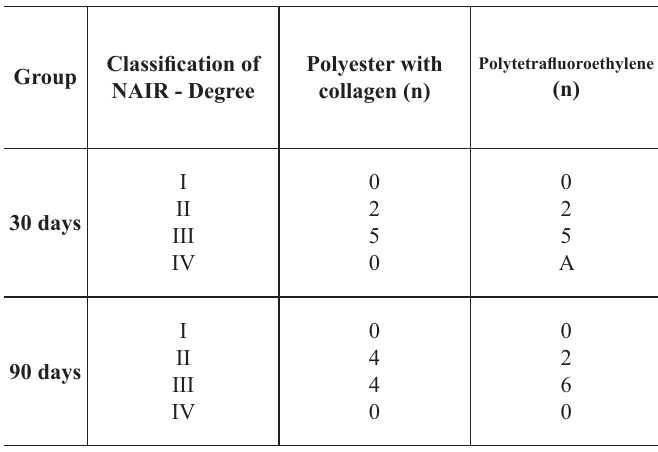
TABLE 1 – Intraperitoneal adhesions.